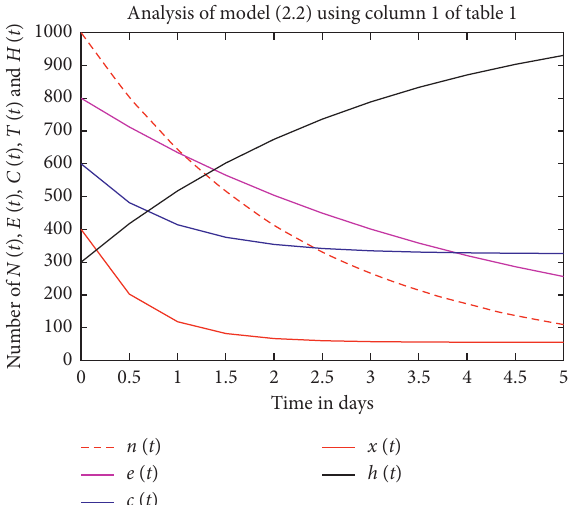
Figure 2: Phase portrait of our model for R